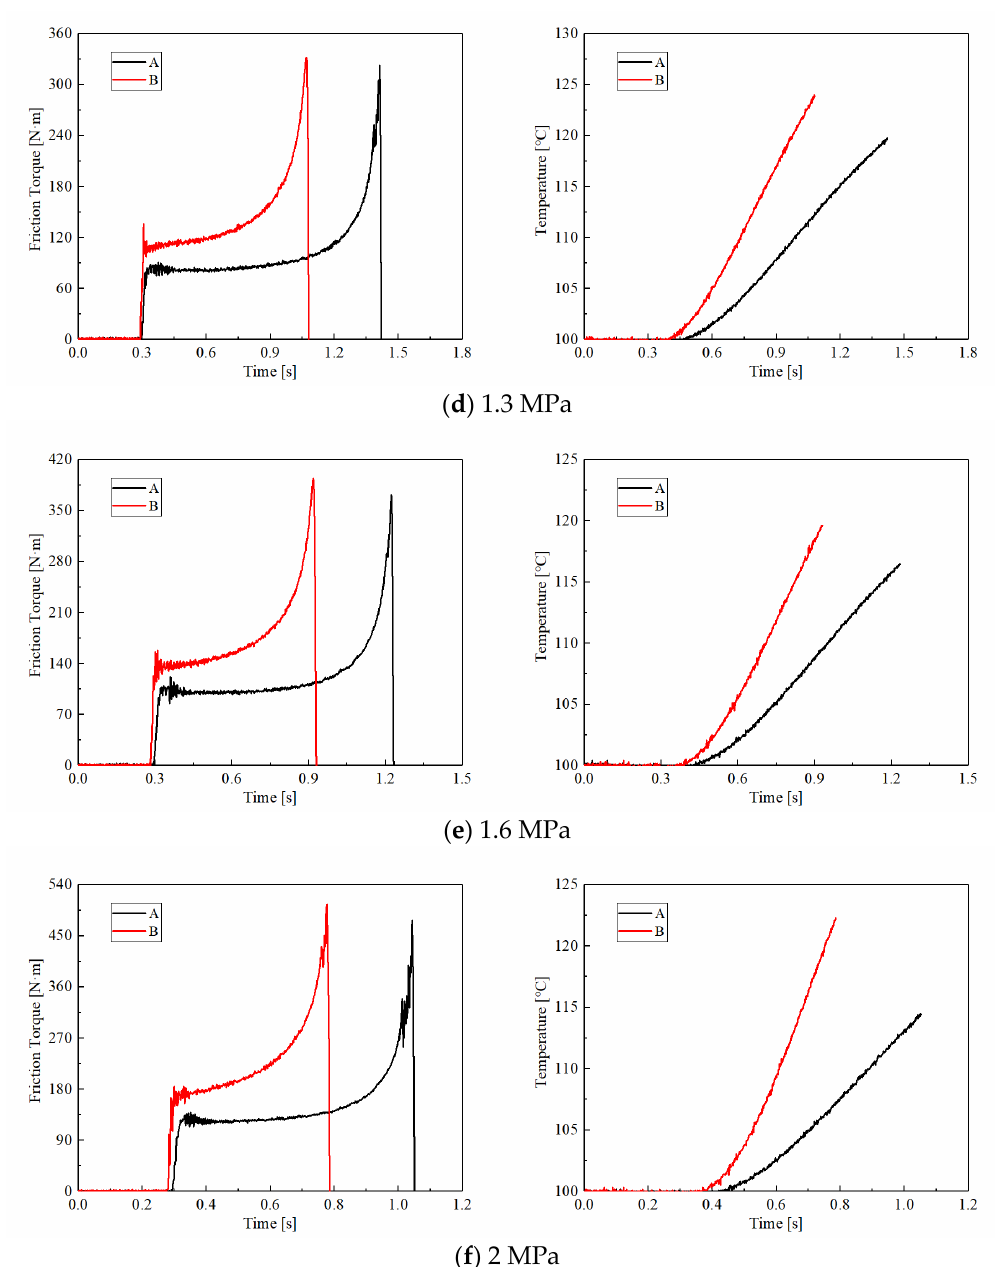
Figure 4. Variations of the friction torques and surface temperatures of CBFM-A and CBFM-B under different applied pressures ( a – f ).